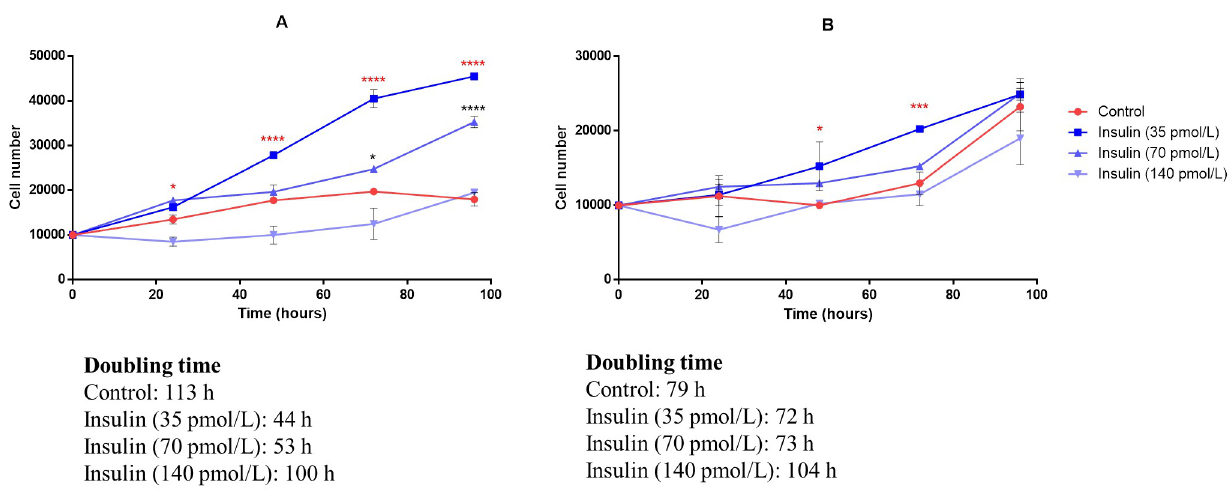
Fig 9. Growth curves of proliferative cells and insulin effect. Growth curves of cells isolated from T . solium racemose larvae (A) and T . crassiceps cyst (B). Insulin at 35 pmol/L produced a significant increase in racemose larvae cells after 24 h (red asterisks) and 70 pmol/L after 72 h with (black asterisks). In the case of T . crassiceps , cells increased significantly with 35 pmol/L after 48 hours (red asterisks). Higher concentration (140 pmol/L) slowed growth in both cultures. Asterisks indicate statistically significant differences between groups (treated and control). One-way ANOVA test ( � p < 0.05; ��� p < 0.001; ���� p < 0.0001).